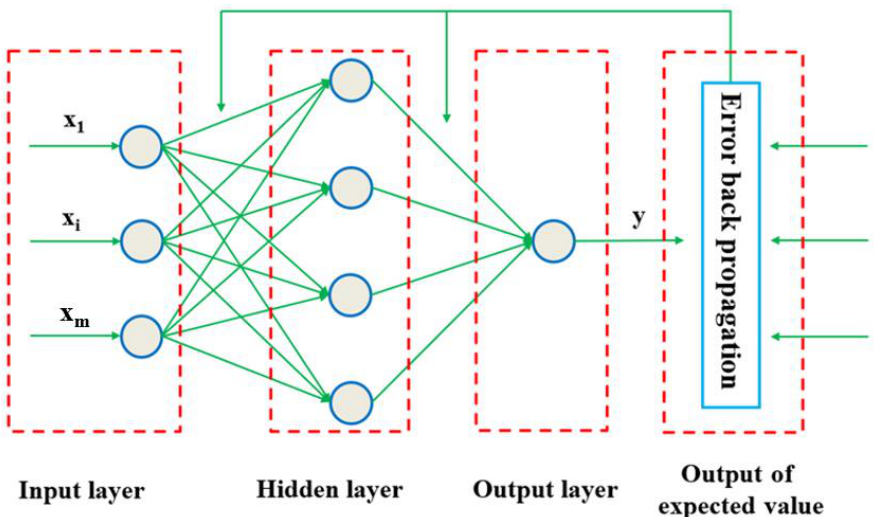
Figure 5. Schematic diagram of BP neural network structure.